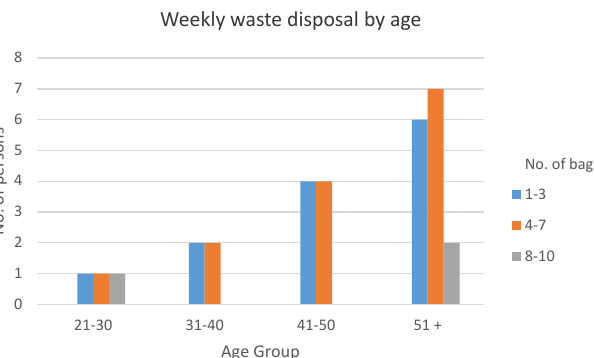
Fig. 8: Quantity of garbage disposed by